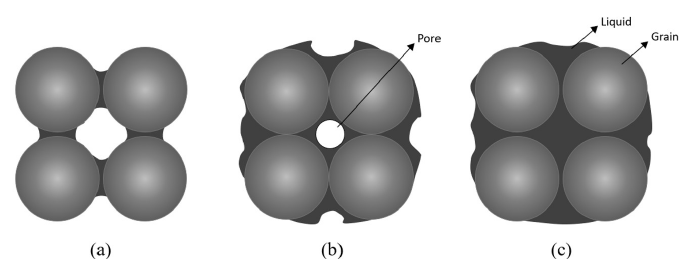
Figure 3. Different conditions of grain-water interaction in mixtures: (a)Pendular state, (b) Funicular state and (c) Saturated